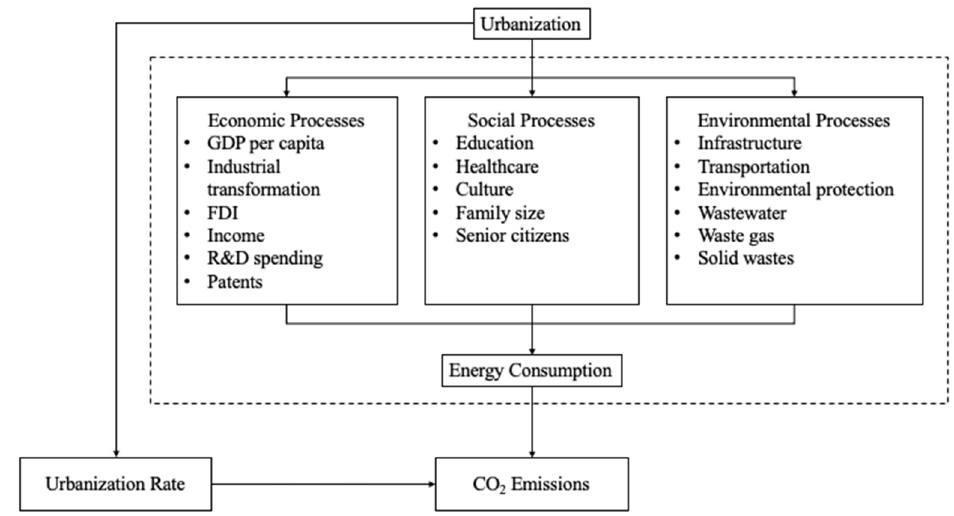
Figure 1. An integrated model of the relationship between urbanization and carbon dioxide emis- sions.